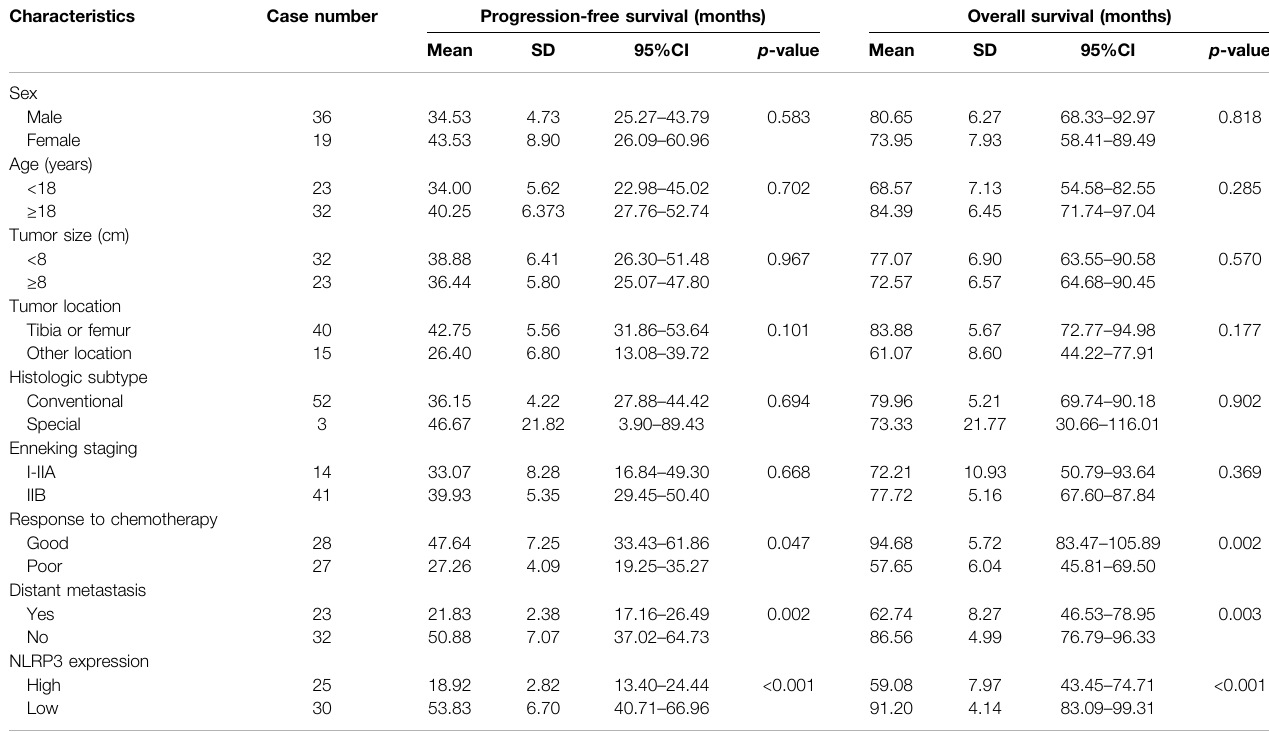
TABLE 2 | Univariate analysis of NLRP3 expression and osteosarcoma patients survival.